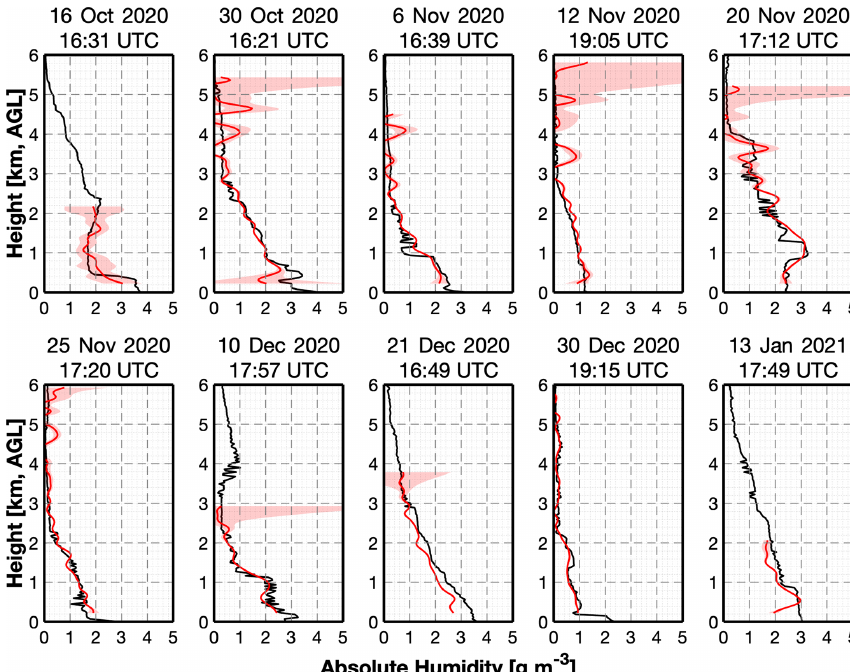
Figure 15. Absolute humidity profiles from the Marshall field site. The black lines are measurements from the radiosondes. The red lines are measured by the MPD; the red shading indicates the error estimates from the bootstrapping procedure. The radiosonde data were provided by the NOAA Global Monitoring Laboratory.